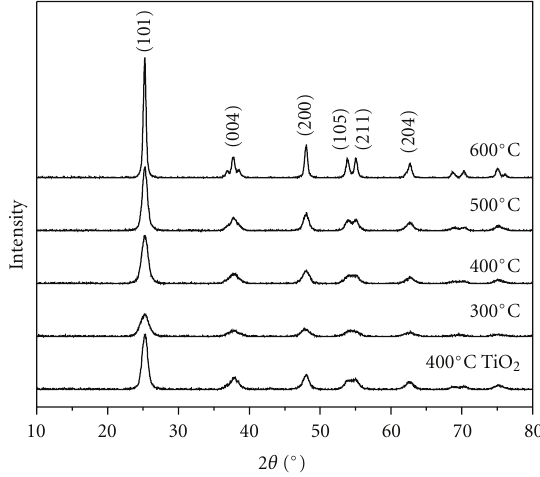
Figure 1: XRD patterns of 3% B-TiO 2 samples with di ff erent calcination temperatures and the pure TiO 2 calcinated at 400 ◦